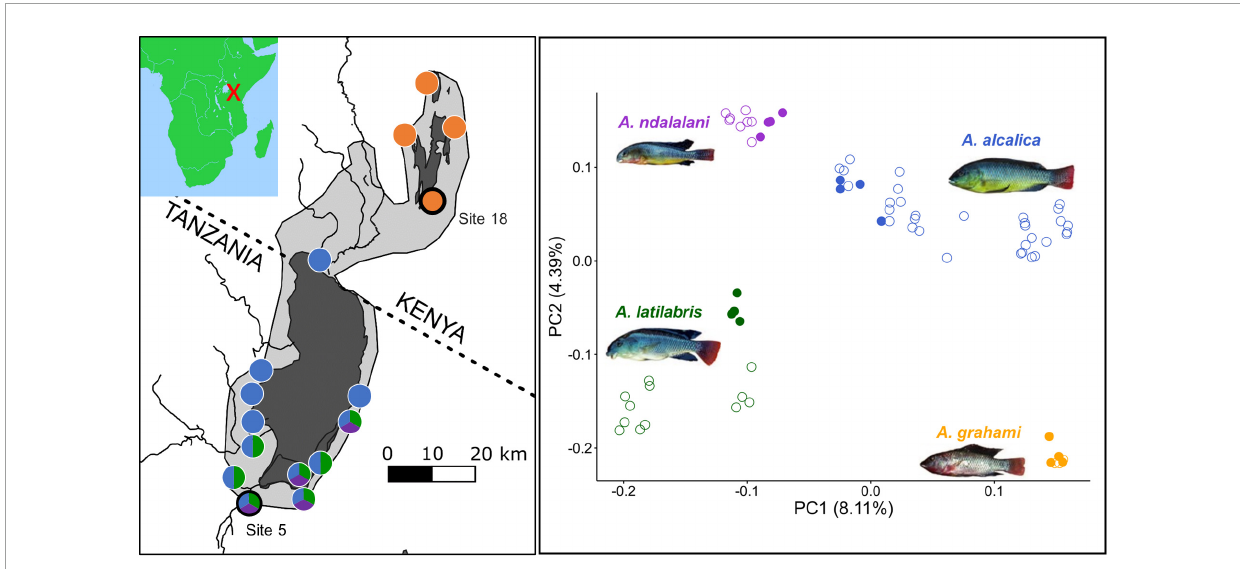
FIGURE1 The Alcolapia spp. radiation of lakes Natron and Magadi. (Left panel): Map showing the distribution of the species from sites that have been sampled. The light gray area shows the approximate maximum extent of Palaeolake Orolonga ( ∼ 700 Ka) (Williamson et al., 1993). The dark gray area represents the current expanse of the lakes. Colored circles correspond to species present in the right panel with black-ringed circles denoting the populations used in this study. Photos and site information are from Ford et al. (2015). (Right panel) : Principal Component Analysis (PCA) of a published Alcolapia RADseq dataset (Ford et al., 2015) demonstrates that the species form distinct genetic clusters even in sympatry. (Left panel) : Colors correspond to species. Filled circles represent the populations used in this study (site five for sympatric species and site 18 for A. grahami , the allopatric species); empty circles are individuals from other sites. The covariance matrix was created using PCAngsd (Meisner and Albrechtsen, 2018) using a genotype likelihood file output from ANGSD (Korneliussen et al.,